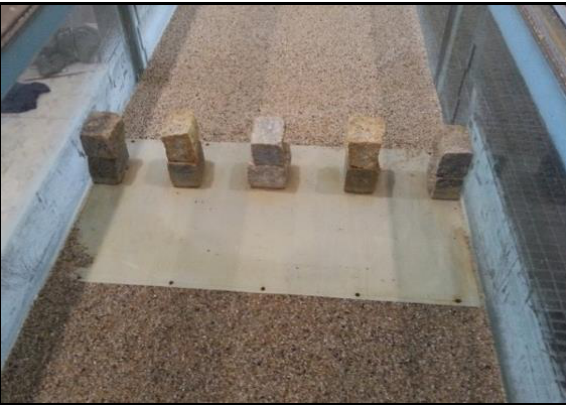
Figure 8. Variant III of the flume development.